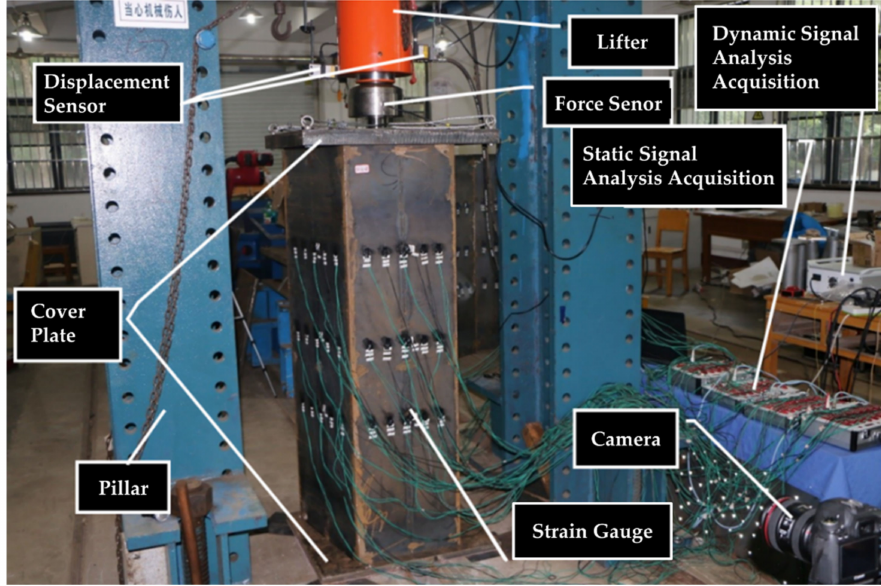
Figure 7. Arrangement of test equipment.